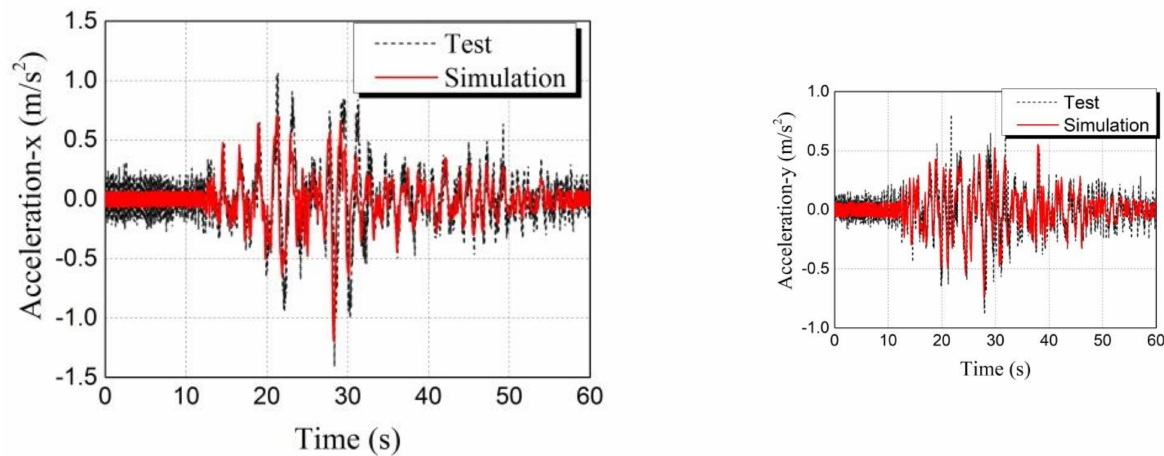
Figure 36. Comparisons between experimental and simulated results of the b300d380 bearing under ELcentro-BCJ ground motion (medium-frequency) with PGA of 4 m/s 2 .